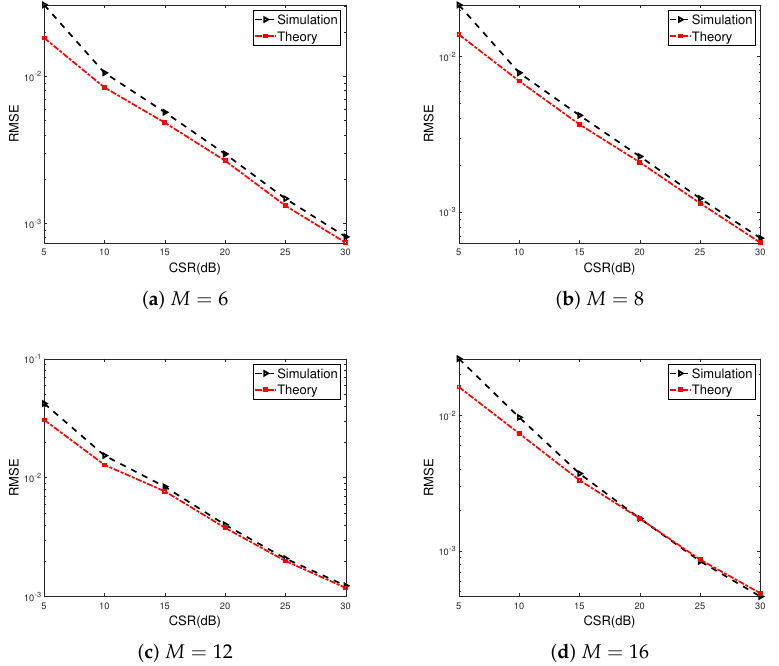
Figure 3. Gain-phase error estimation performances of the proposed method for small-scale ULAs versus CSRs, SNR = 40dB, K 0 = 20, T = 80, N = 40. ( K 0 : the number of random error vectors, N : the number of signal snapshots needed to form one random error vector without the calibration signals, T : the number of signal snapshots needed to estimate the SAUNSV with the calibration signals, M : the number of array elements).